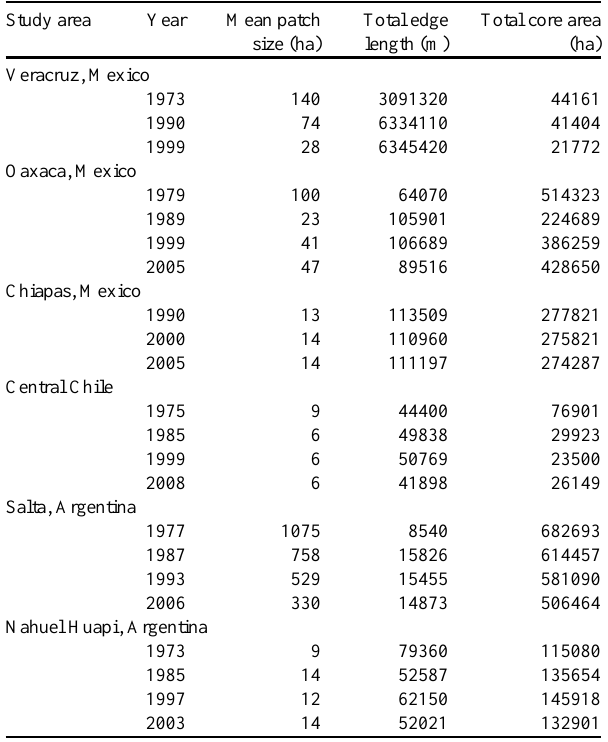
Table 2 . Changes in landscape metrics recorded over time for six study areas. Analyses were derived from satellite remote sensing imagery, using FRAGSTATS (see text). Adapted from Newton and Tejedor